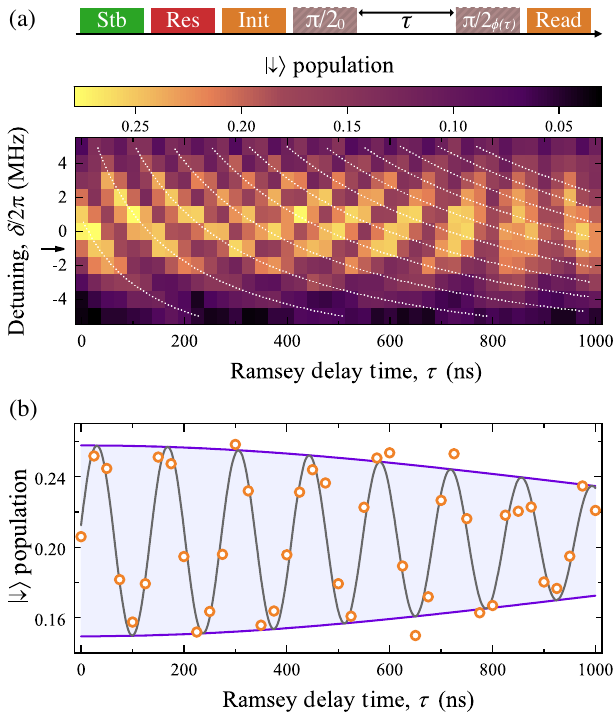
FIG. 3. Ramsey interferometry. (a) Ramsey pulse sequence with two π = 2 pulses separated by a delay time τ (top). The phase of the second pulse is swept according to ϕ ¼ τω S , where ω = 2 π ¼ 5 MHz. The color indicates j ↓ i population plotted as S a function of τ and the two-photon detuning, δ . Dotted white curves provide a guide to the eye for the expected j ↓ i population τ þ α Þ at recovery. Fits of the form a exp ½ − ð τ =T (cid:2) 2 Þ 2 (cid:3) sin ð ω Ramsey = 2 π ¼ each δ yield an average T (cid:2) 2 ¼ 1 . 3 ð 3 Þ μ s and Δ ac 3 . 3 ð 5 Þ MHz (see Supplemental Material [61] Sec. IX). (b) Line cut at δ = 2 π ¼ − 1 MHz indicated by an arrow in (a), where the j ↓ i population (orange circles) is measured as a function of τ . The black curve corresponds to the fit described in (a), where ω = 2 π ¼ 7 . 27 ð 3 Þ MHz, T (cid:2) ¼ 1 . 4 ð 3 Þ μ s, a ¼ 0 . 054 ð 4 Þ , 2 Ramsey and α ¼ 0 . 16 ð 9 Þ . The purple shaded region is bounded by the envelope (cid:4) a exp ½ − ð τ =T (cid:2) 2 Þ 2 (cid:3)